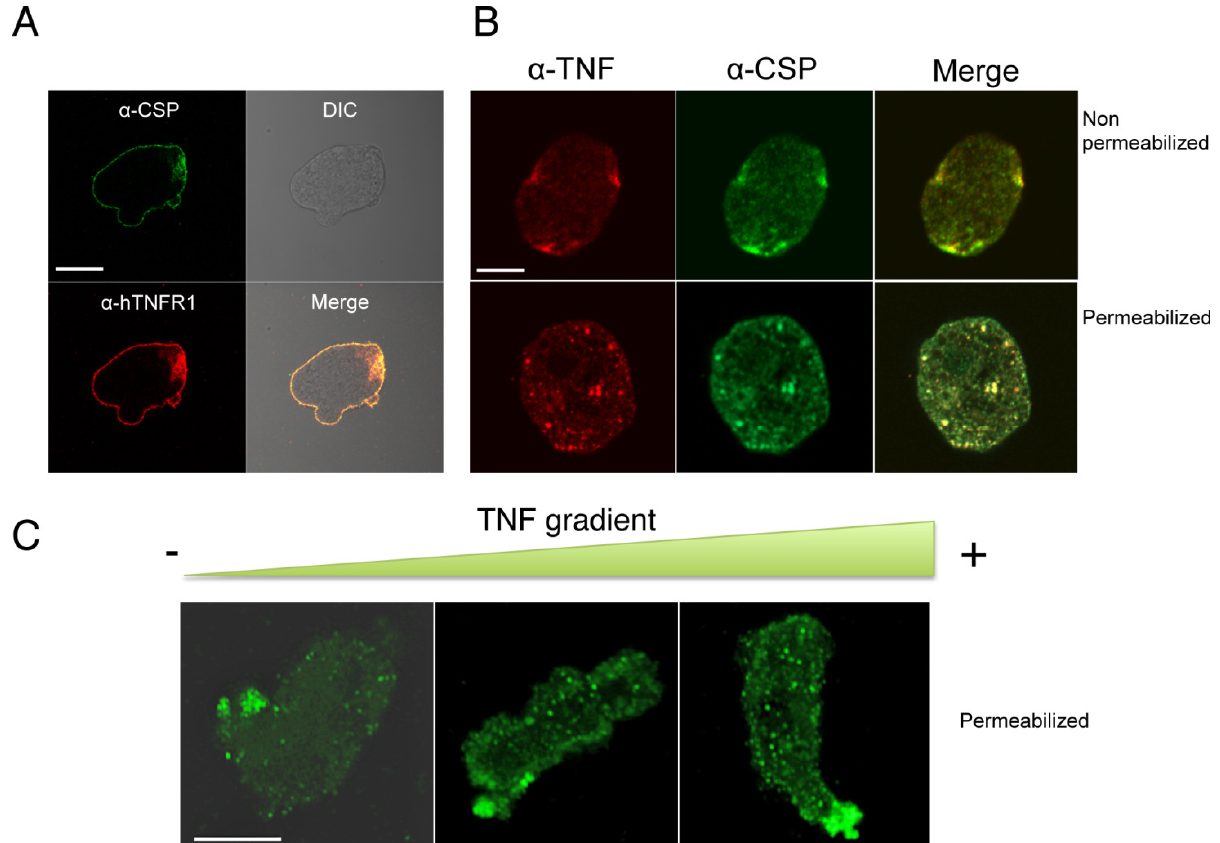
FIGURE 3: Cellular localization of CSP in Entamoeba histolytica . (A) Immunolocalization of CSP (green) and hTNFR1 (red) in fixed but non- permeabilized trophozoites revealed that both proteins are located at the plasma membrane. Scale bar: 10 µm. (B) Immunolocalization of CSP in E. histolytica incubated with a homogenous (non-gradient) concentration of TNF. Trophozoites were incubated with 70 nM TNF, fixed and permeabilized or not. CSP (green) and TNF (red) were co-localized at the trophozoite surface. CSP was detected as described for Fig. 3A. TNF was detected with 1E12 monoclonal antibody and mouse-Cy3 (dilution: 1:200). Scale bar: 10 µm. (C) Immunolocalization of CSP in E. histolytica incubated with a TNF gradient. Trophozoites exposed to a TNF gradient for 2 h were fixed and permeabilized. During trophozoite migration toward the TNF source, CSP (green) concentrated in the rear part of the cells (i.e. distal to the TNF source). The nucleus was stained with DAPI (blue). Scale bar: 10